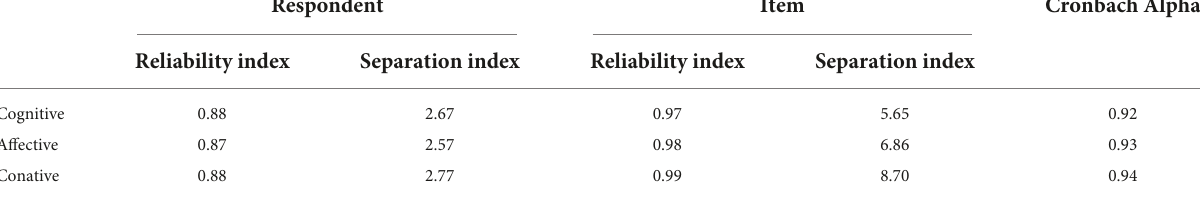
TABLE 2 Reliability index and separation